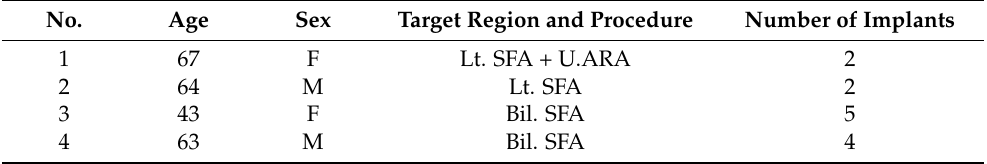
Table 2. Summary of patient